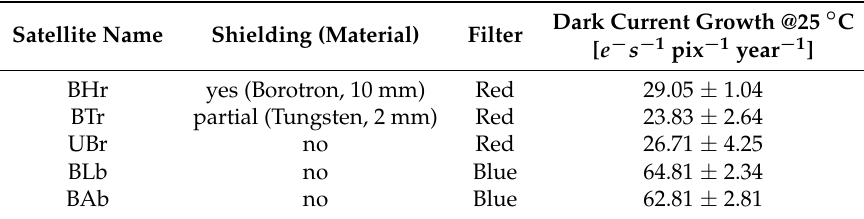
Table 2. Increase of dark current in BRITE